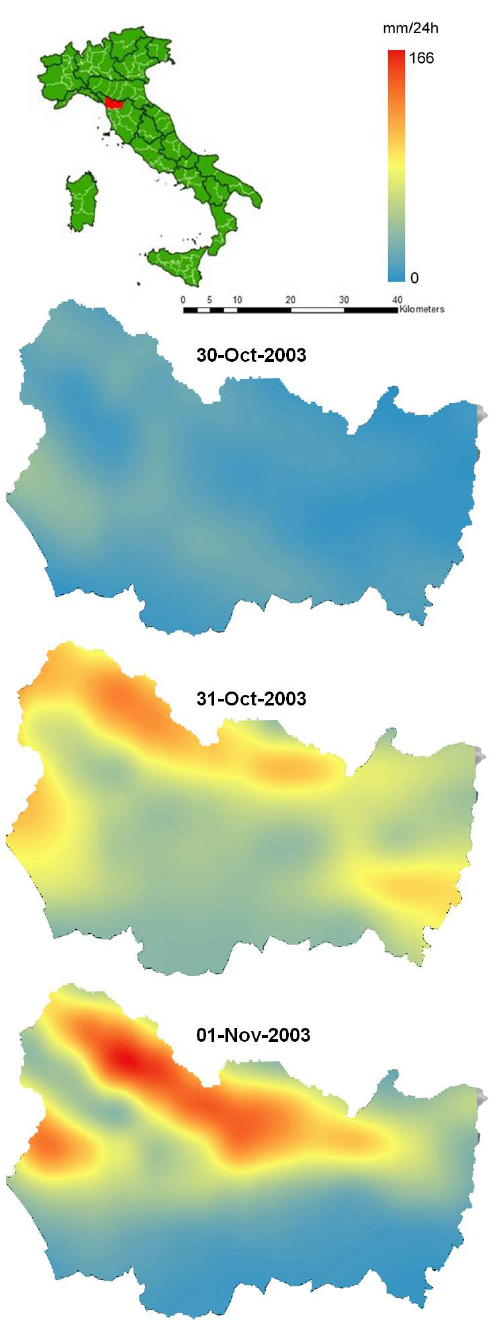
Fig. 2. Daily rainfall amounts obtained from the downscaled rainfall